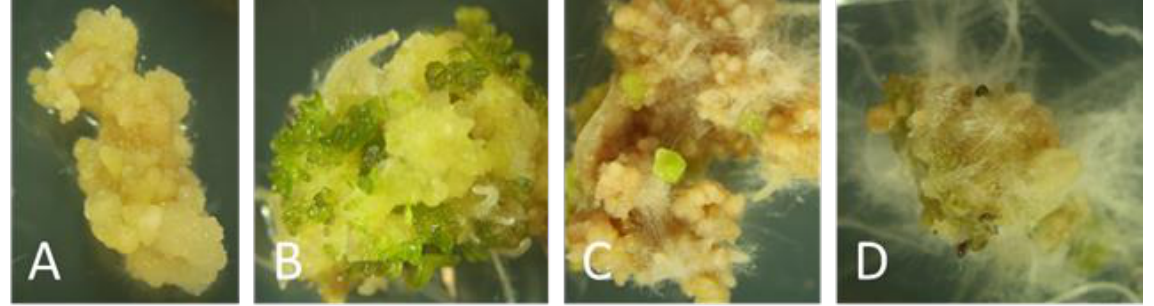
Figure 2. Varied response (organogenesis) of 4-5-week-old callus ( A ) of Arabidopsis arenosa initiated